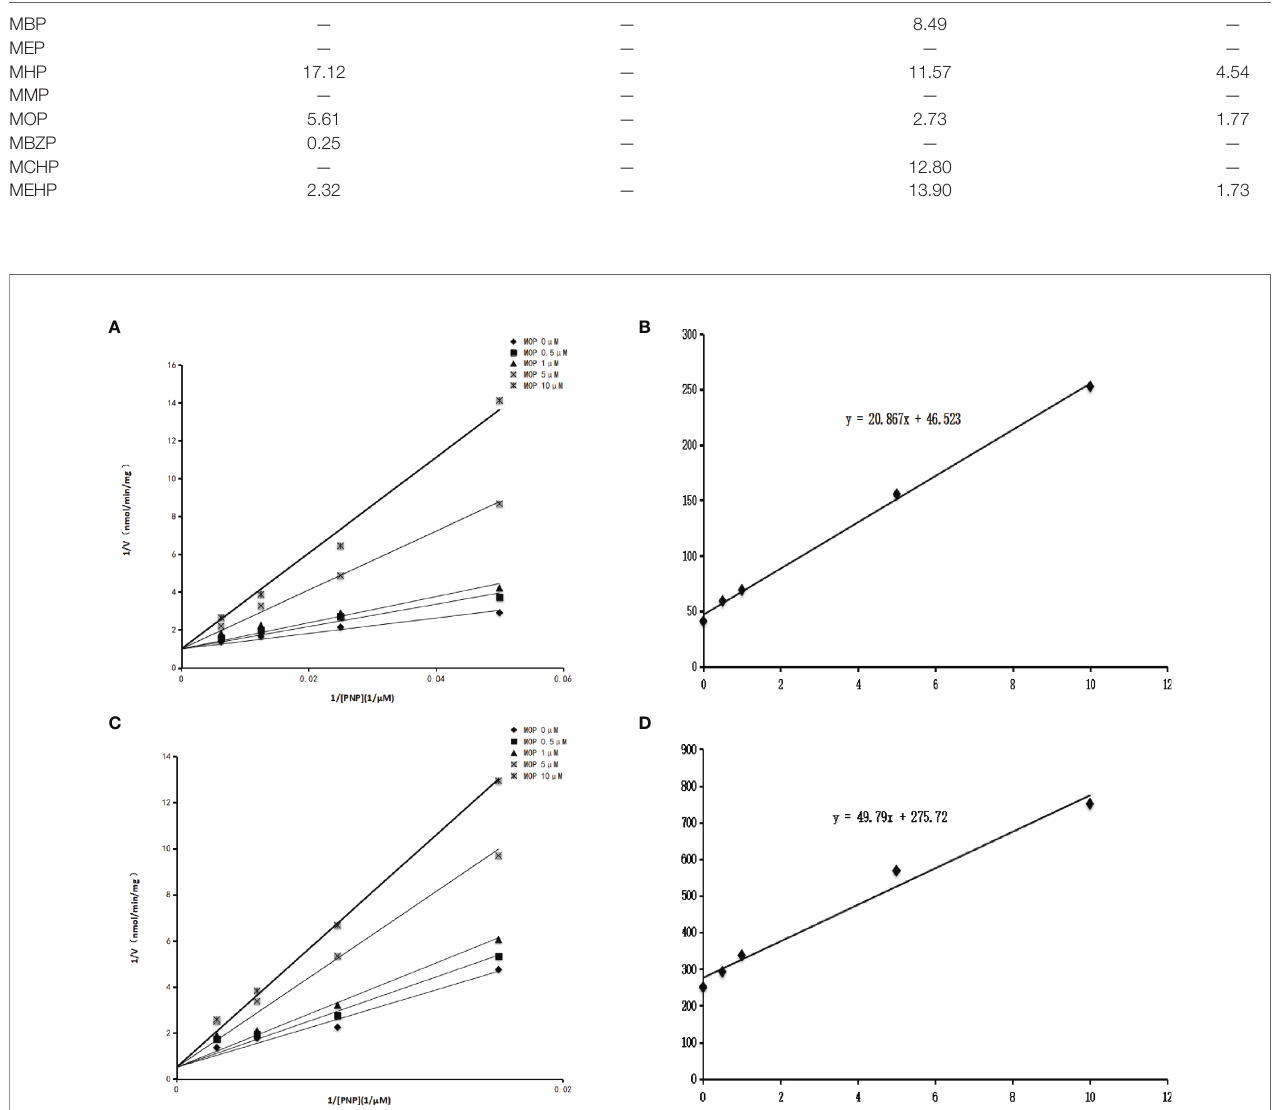
FIGURE 4 | Inhibition kinetics of MOP on SULT1B1 and SULT1E1. Lineweaver – Burk plot of the inhibition of MOP on the activity of SULT1B1 (A) and SULT1E1 (B) . Each data point represents the mean value of duplicate experiments. Determination of inhibition kinetic parameter ( K i ) of MOP on the activity of SULT1B1 (C) and SULT1E1 (D) using the second plots. The vertical axis represents the slopes of the lines from Lineweaver – Burk plots, and the horizontal axis represents the concentrations of